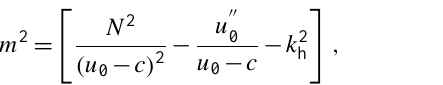
map are the TIMED/SABER sounding on 16 June, and the hours are in local time. The selected sounding, at 02:09 LT, was chosen for the propagation condition analysis because it was the nearest sounding point to Ferraz, located almost within the field of view of the